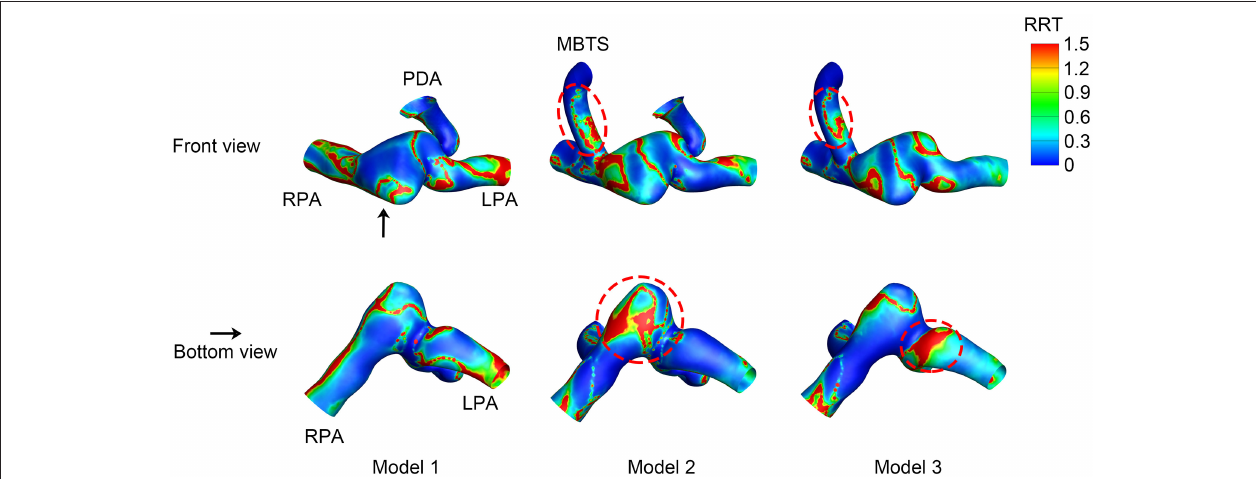
FIGURE 7 | Relative residence time (RRT). The upper row is the front view, and the lower row is the bottom view of each model except for the aorta. The black arrow indicates the perspective of the bottom view. PDA, patent ductus arteriosus; MBTS, modified Blalock-Taussig shunt; LPA, left pulmonary artery; RPA, right pulmonary artery.